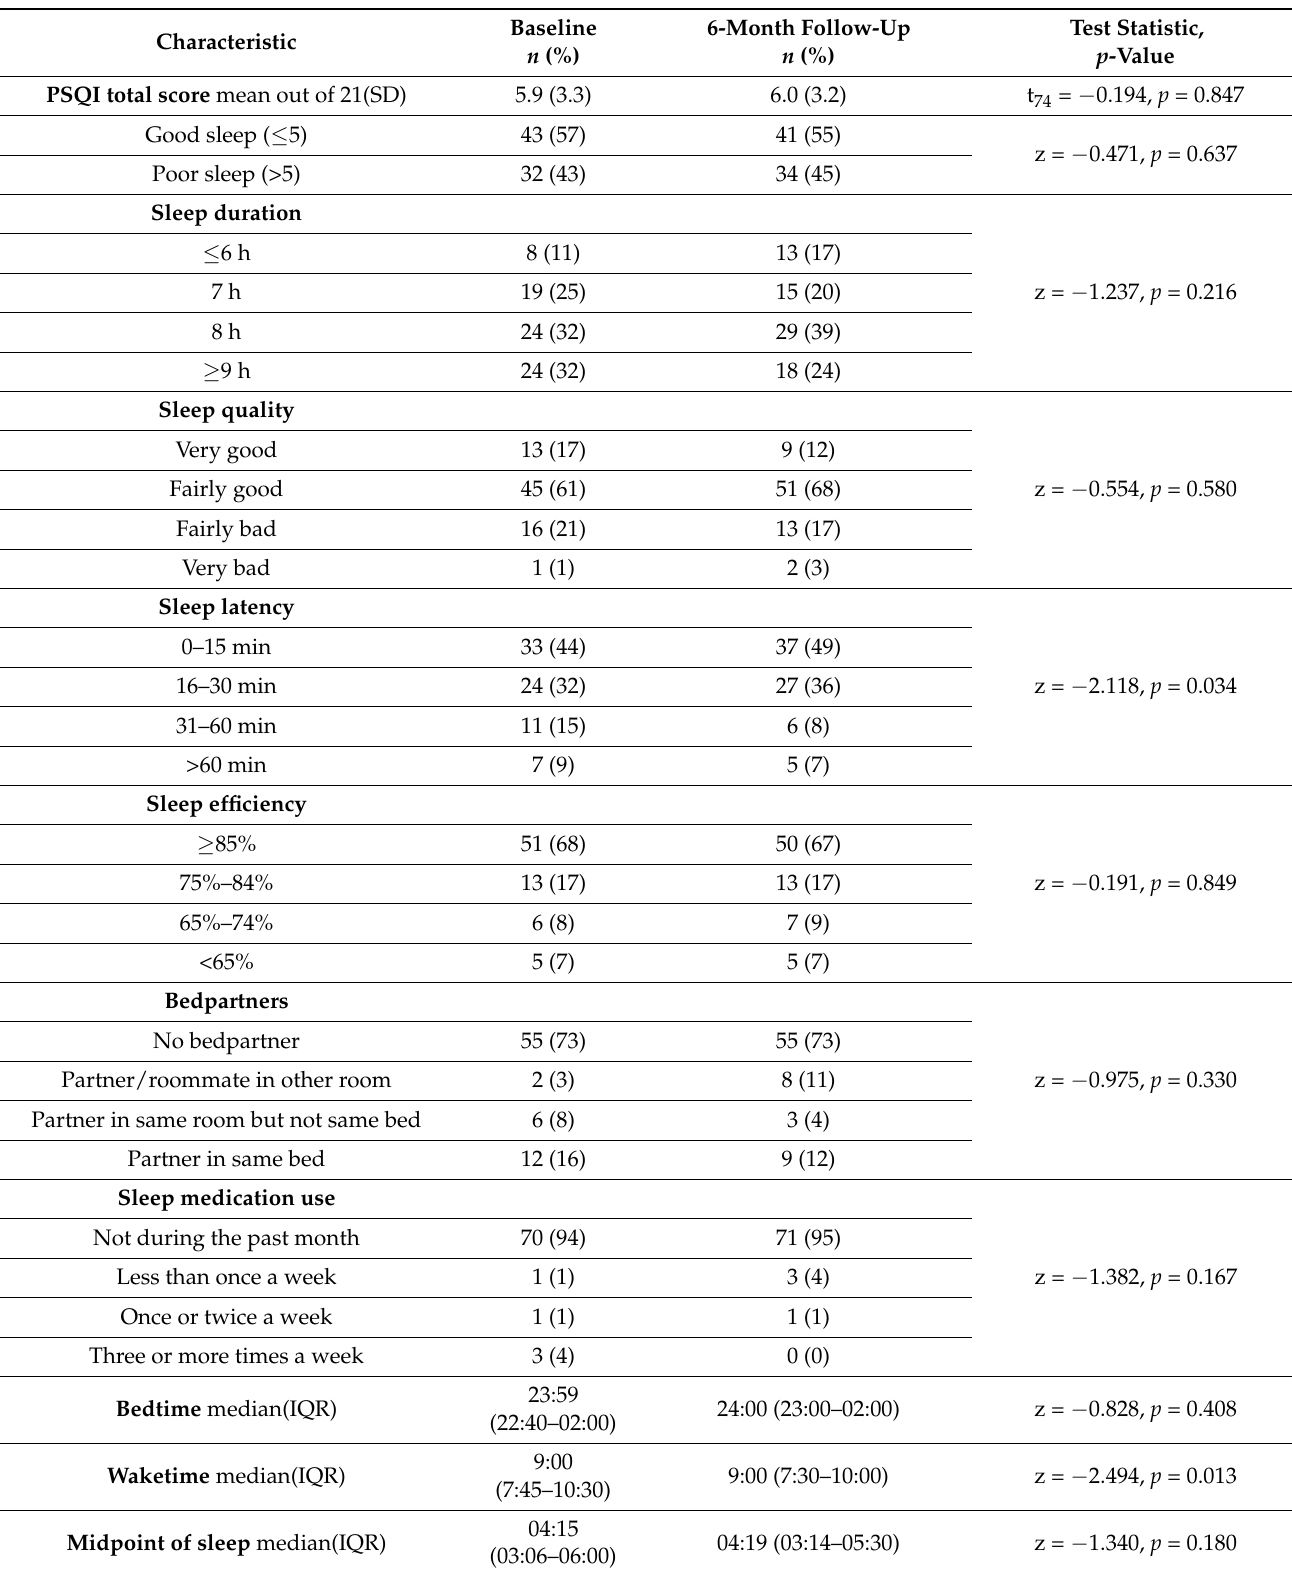
Table 4. Pittsburgh Sleep Quality Index (PSQI) scores and sub-components before and 6 months after completion of a sleep and circadian education course ( n =